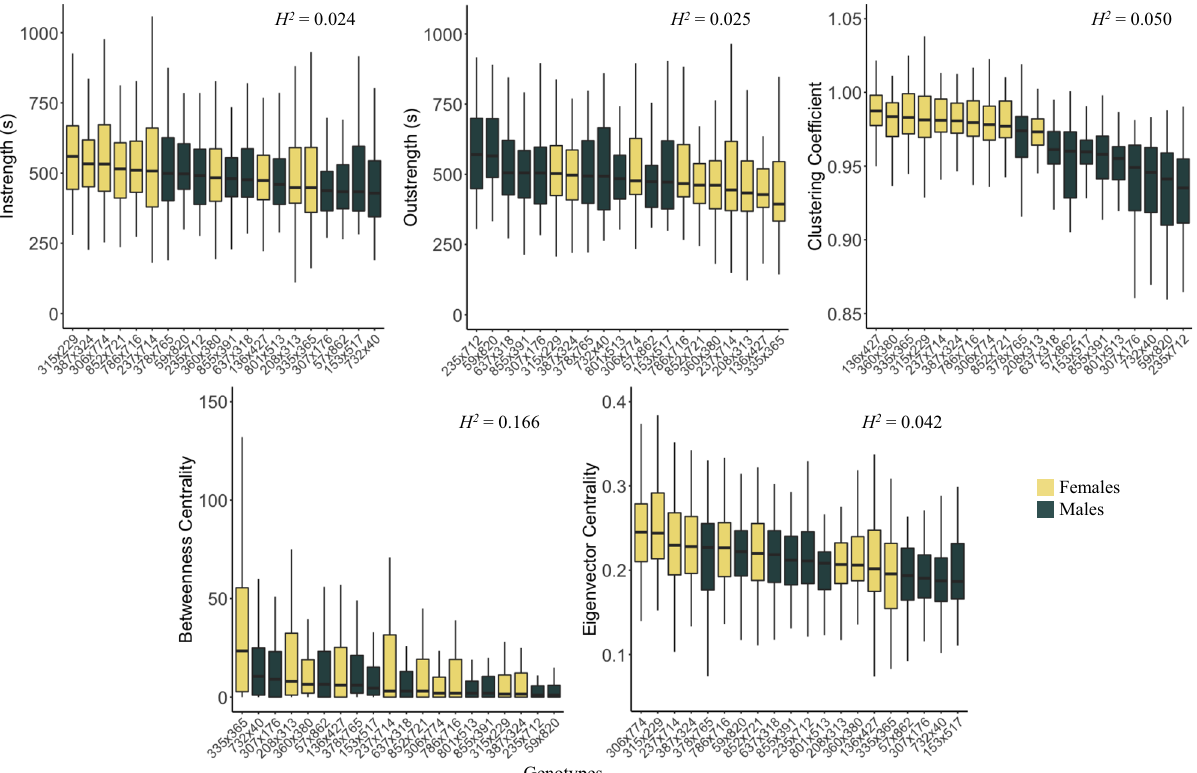
Fig. 1 Genotypic effects on network position. Twenty heterozygous Drosophila melanogaster genotypes signi fi cantly differed in fi ve commonly studied measures of social network position (all LRT, P R < 0.05). Broad-sense heritability estimates ( H 2 ) for each network position are presented in each panel. Boxplots present the medians (horizontal lines), interquartile ranges (boxes), and values within ± 1.5x IQR (whiskers) for each genotype ( n for each genotype = 56). Genotypes are ordered in each panel by their median value for each network position. Genotype labels are presented as the maternal parent genotype number, crossed with ( “ x ” ) the paternal genotype number. Genotype numbers are arbitrary and unindicative of any similarities/ differences between genotypes. The sex of each genotype is indicated by the color- fi ll of the boxplots (yellow = females, navy = males). Source data are provided as a Source Data fi